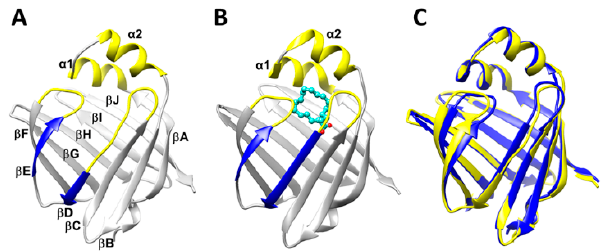
Figure 1. Structure of heart fatty acid binding protein (HFABP): ( A ) The 3D structure of ligand-free HFABP (apo-HFABP, PDB ID: 3RSW). The dynamic portal region is colored in yellow, and the β D and β E are colored in blue. ( B ) The 3D structure of ligand-binding HFABP (holo-HFABP, PDB ID: 3WXQ). The stearic acid is shown in ball-and-stick form. ( C ) The overlap of the experimental structures of apo- and holo-HFABP.